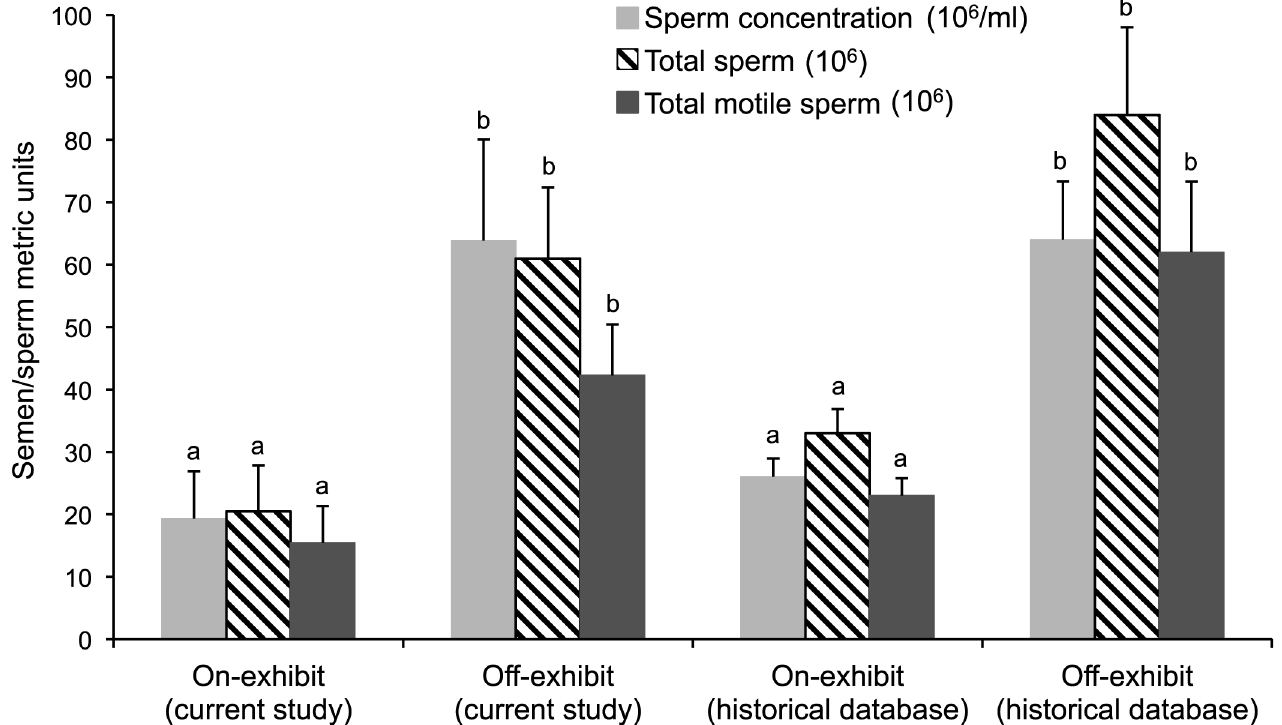
Fig 2. Mean ( ± SEM) ejaculate traits for male cheetahs (n = 23) managed in ex situ collections in the current study or from those in our institution ’ s historical database (n = 159 ejaculates) that were housed on- or off-exhibit. Superscripts represent differences ( P < 0.05) in ejaculate metrics between the two conditions (on- or off-display) within the current or historical dataset.